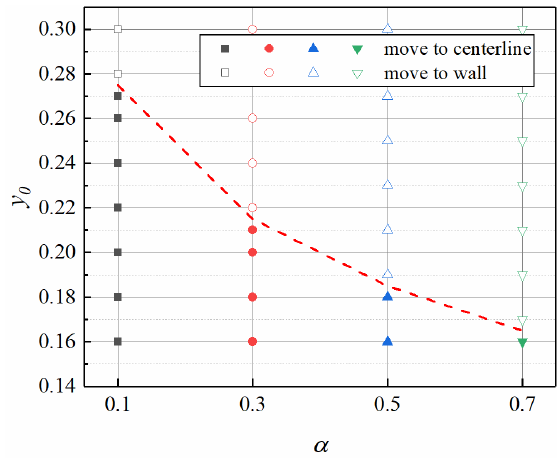
Figure 14. Direction of particle migration for different particle initial positions and mobility parameters. ( Wi = 0.5, η r = 0.3, ε = 0.3).